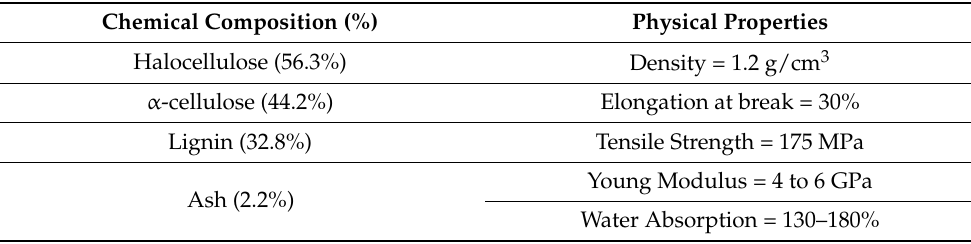
Table 1. Chemical Composition and Physical Properties of Coconut Fibre